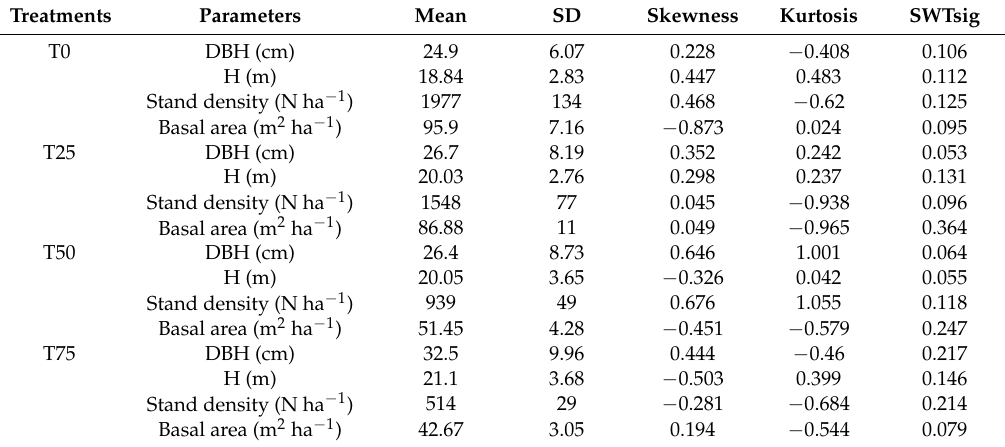
Table 1. The main parameters measured and the related structural characteristics for the four treatments analyzed (DBH: diameter at breast height; H; total tree height; N ha − 1 : number of trees per hectare; SD: standard deviation; SWTsig: p -values of the Shapiro–Wilk Test).